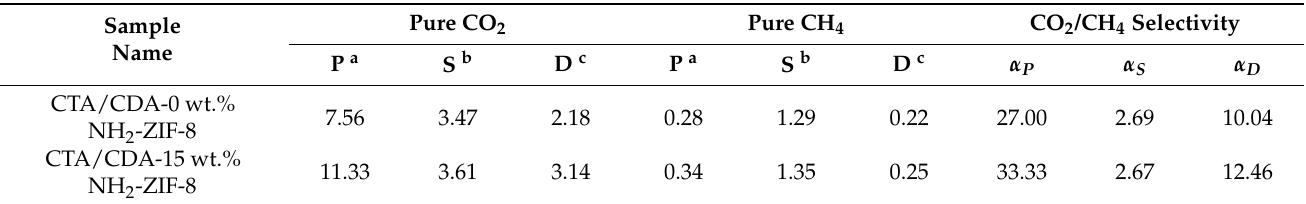
Figure 8. Sorption isotherms of CO 2 (closed symbols) and CH 4 (open symbols) in the pristine CTA/CDA-0 wt.% NH 2 -ZIF-8 (solid blue line) and CTA/CDA-15 wt.% NH 2 -ZIF-8 MMM (solid red line) as a function. Table 2. Calculated pure gas permeabilities (Barrer), solubility coe ffi cients (10 ⁻ 2 cm 3 (STP)/cm 3 cm Hg), diffusivity coeffi- cients (10 ⁻⁸ cm 2 /s), and corresponding selectivities of CO ₂ and CH ₄ for CTA/CDA-0 wt.% NH ₂ -ZIF-8 and CTA/CDA-15 wt.% NH ₂ -ZIF-8.